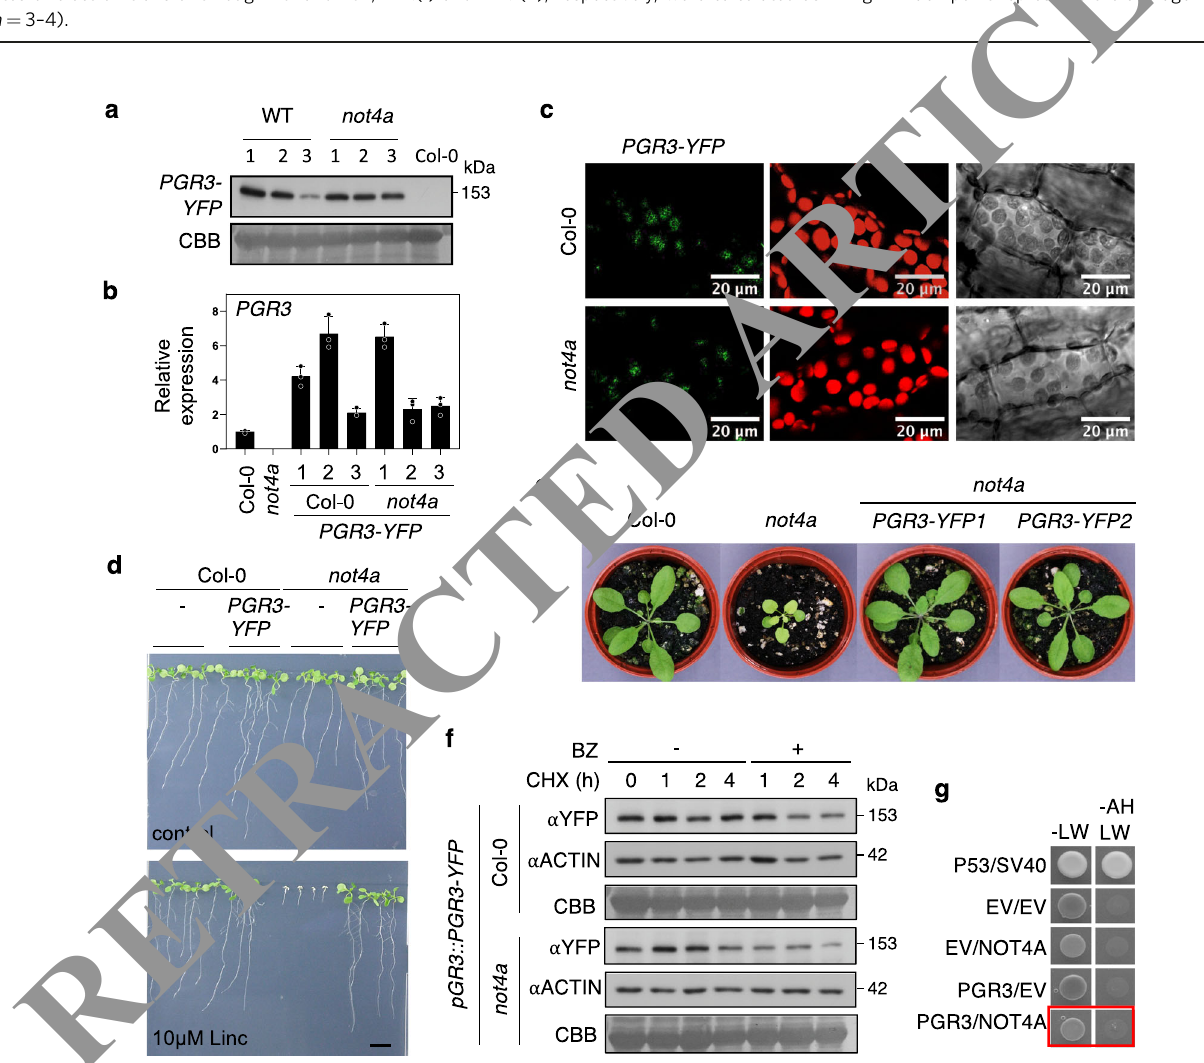
Fig. 7 PGR3 can rescue the chloroplast-associated defects in not4a . a Anti-YFP western blot of steady state PGR3-YFP protein levels in three independent Col-0 and not4a lines expressing pPGR3::PGR3-YFP . b Quantitative PCR (qPCR) of PGR3 in Col-0, not4a and the PGR3-YFP lines from a . Expression levels normalised to ACTIN7 and shown relative to Col-0 WT. n = 3 biological replicates. Error bars = SEM. c Confocal images of hypocotyl cells in Col-0 and not4a lines expressing pPGR3::PGR3-YFP . Panels show PGR3-YFP in green (left), chloroplasts in red (middle) and bright fi eld view (right). Experiment was replicated at least 3 times (see Supplementary Fig. 7D for further repeats). d 10-day-old Col-0, not4a and PGR3-YFP transgenic seedlings grown on vertical plates ±10 µ M lincomycin. Bar = 1 cm. e Representative rosette images of 4-week-old Col-0, not4a and not4a PGR3-YFP lines grown under long day (LD) conditions. Bar = 1 cm. f Cycloheximide (CHX) chase of PGR3-YFP and ACTIN in Col-0 and not4a ± bortezomib (BZ). g Yeast two-hybrid assay between NOT4A and PGR3. EV empty vector. P53/SV40 positive control. Growth on -LW con fi rms successful transformation; growth on -AHLW denotes interaction. Western blots in 7a and 7f were repeated three times with similar results.